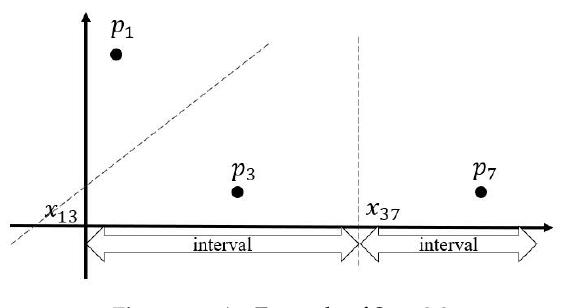
Figure 10. An Example of Step 2.2.